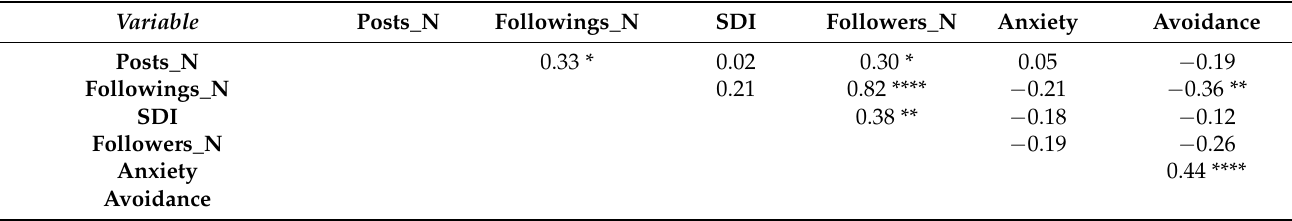
Table 3. Pearson’s r values and significance levels among Instagram number of posts (Posts_N), number of followings (Followings_N), SDI, number of followers (Followers_N) and ECR-R Anxiety and Avoidance. (* p < 0.05, ** p < 0.01, **** p <